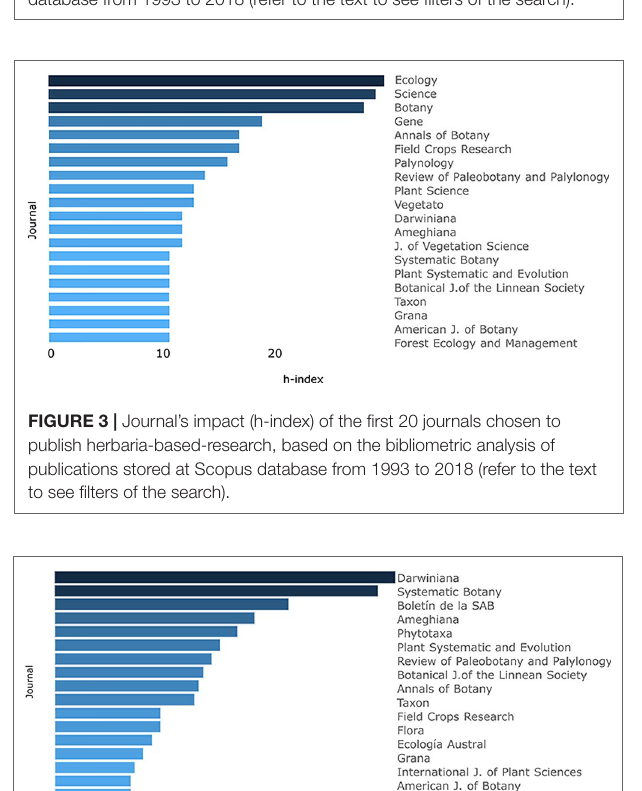
Frontiers in Plant Science |